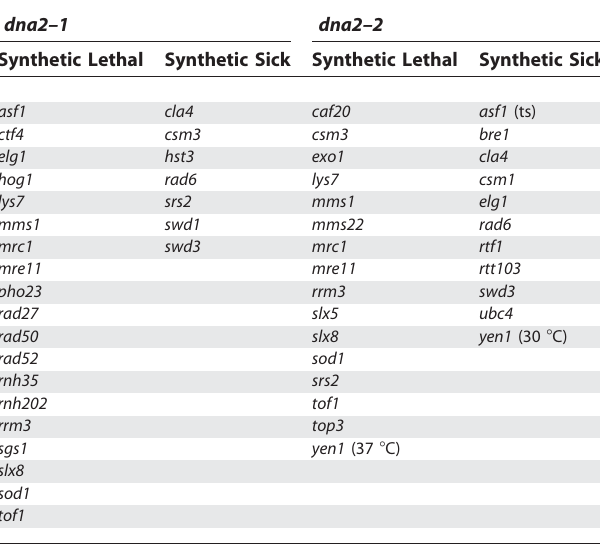
Table 1. Genes Identified as Putative DNA2 Interacters from the SGA Screen with dna2–1 and dna2–2 Queries and Verified by Tetrad Dissection dna2–1